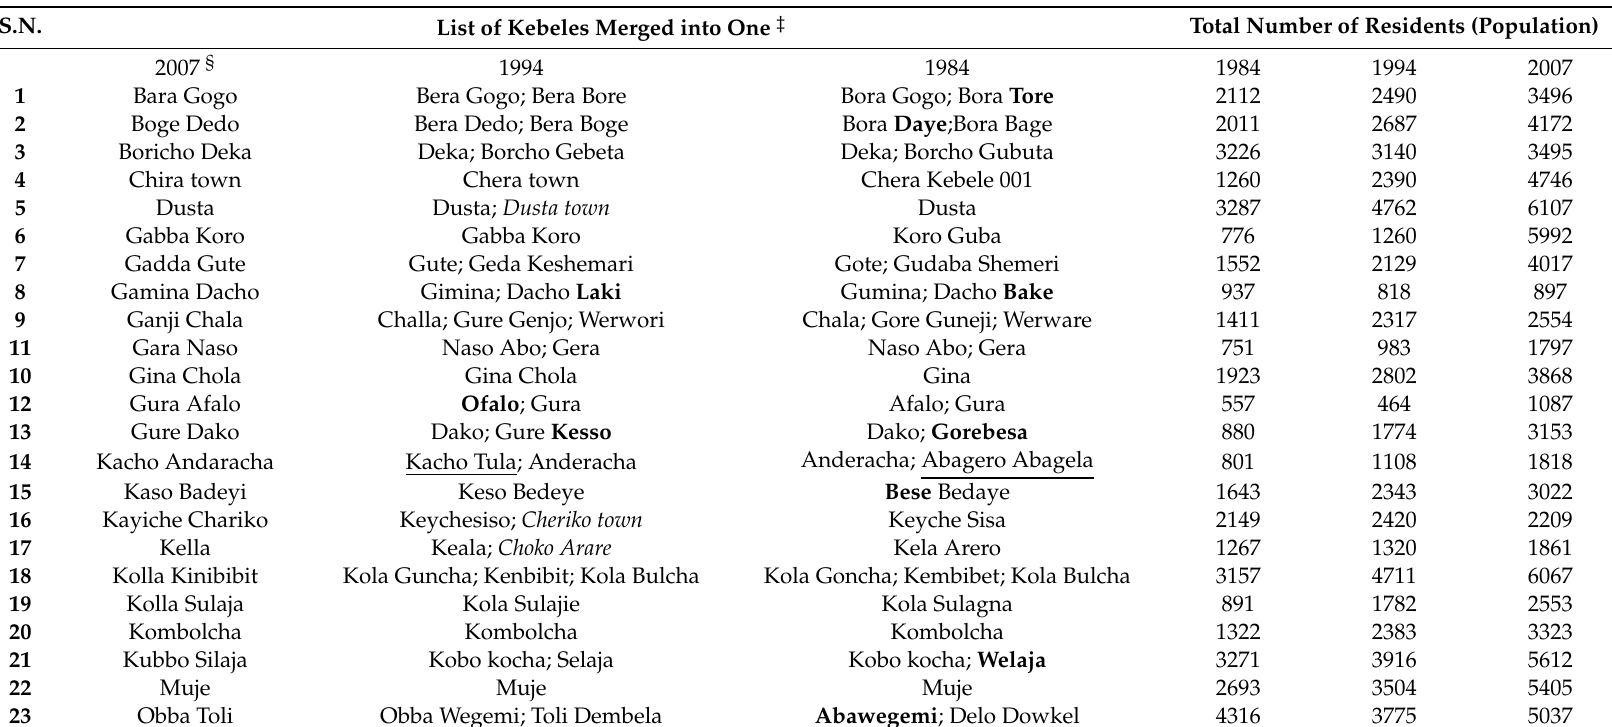
Table A1. List of old kebeles merged to match the kebele s of the 2007 population census and their population numbers. †